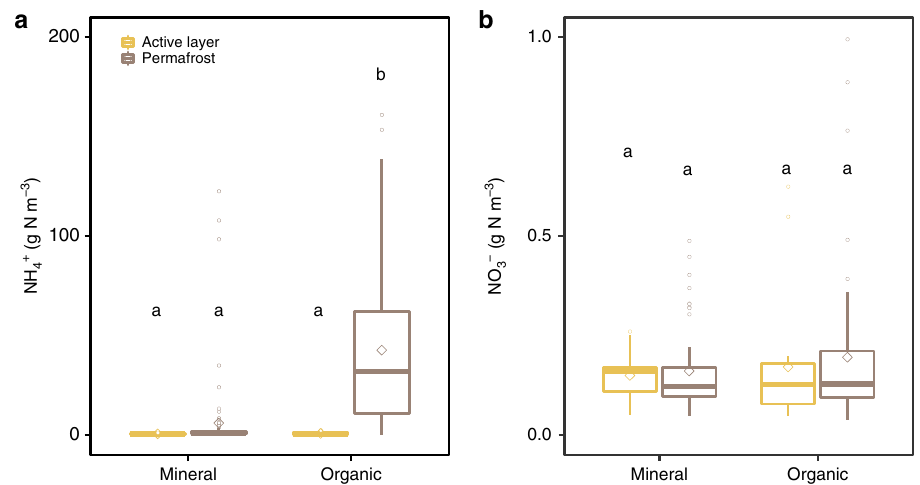
Fig. 2 Pools of ammonium and nitrate in the active layer and permafrost. Samples are grouped by layer type with the following classi fi cation: organic layers (soil C ≥ 12%) and mineral layers (soil C < 12%). Letters indicate signi fi cant differences between thermal layers and soil types indicated by Mann – Whitney U test. The box plots summarize the distribution of a the amounts of ammonium (NH 4 + ) (kg N m − 3 ) and b nitrate (NO 3 − ) (g N m − 3 ) for each layer nature and in the active layer and permafrost. In each box plot, the diamond represents the mean, the horizontal line represents the median, the end of the box the 25 th and 75 th percentiles, and the lines extending from the box are 1.5 interquartile ranges from the median. Data points outside of the 1.5 interquartile ranges are represented as